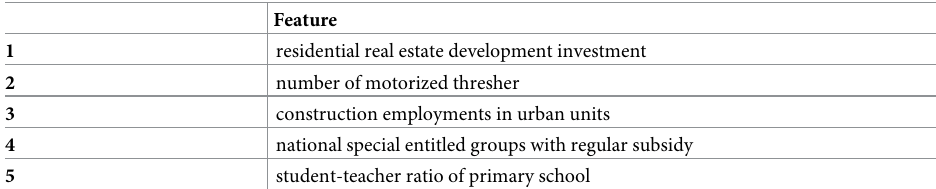
Table 13. 5 features by Wrapper